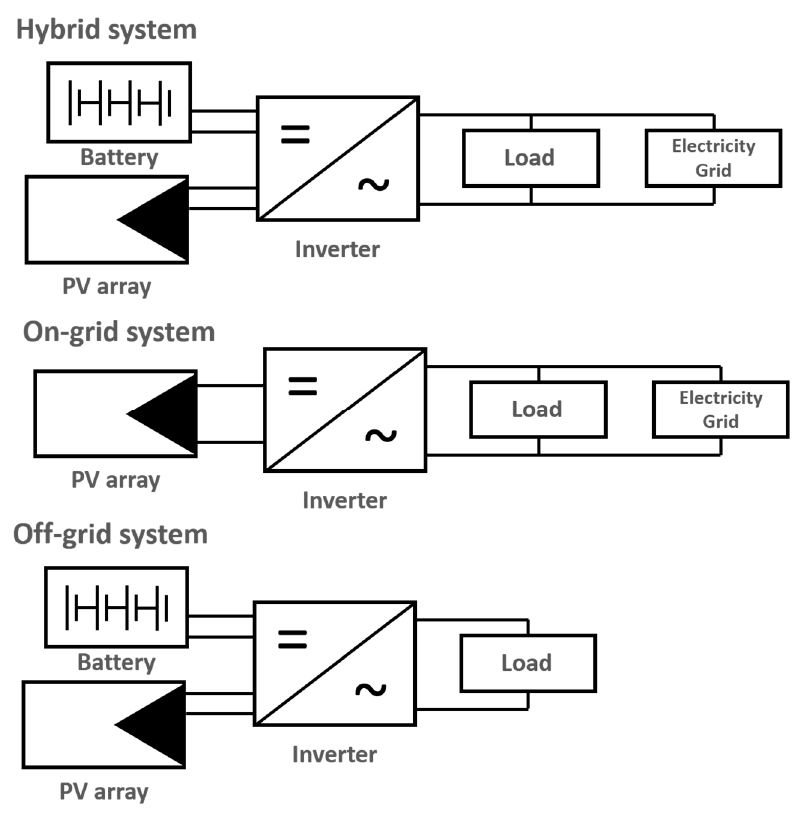
Figure 6. Microgrid working system.